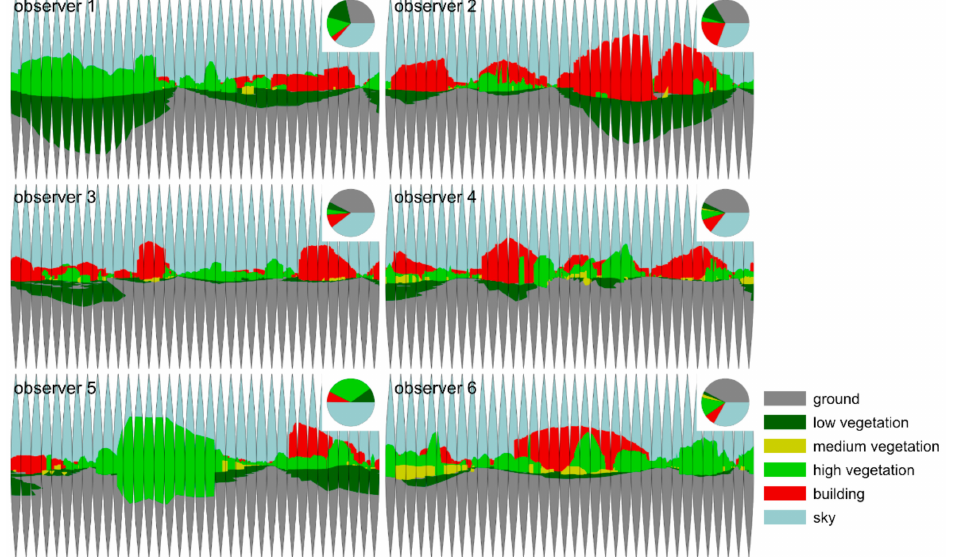
Figure 5. Interrupted sinusoidal projection of rendered images with the distribution of landscape features charts for observers